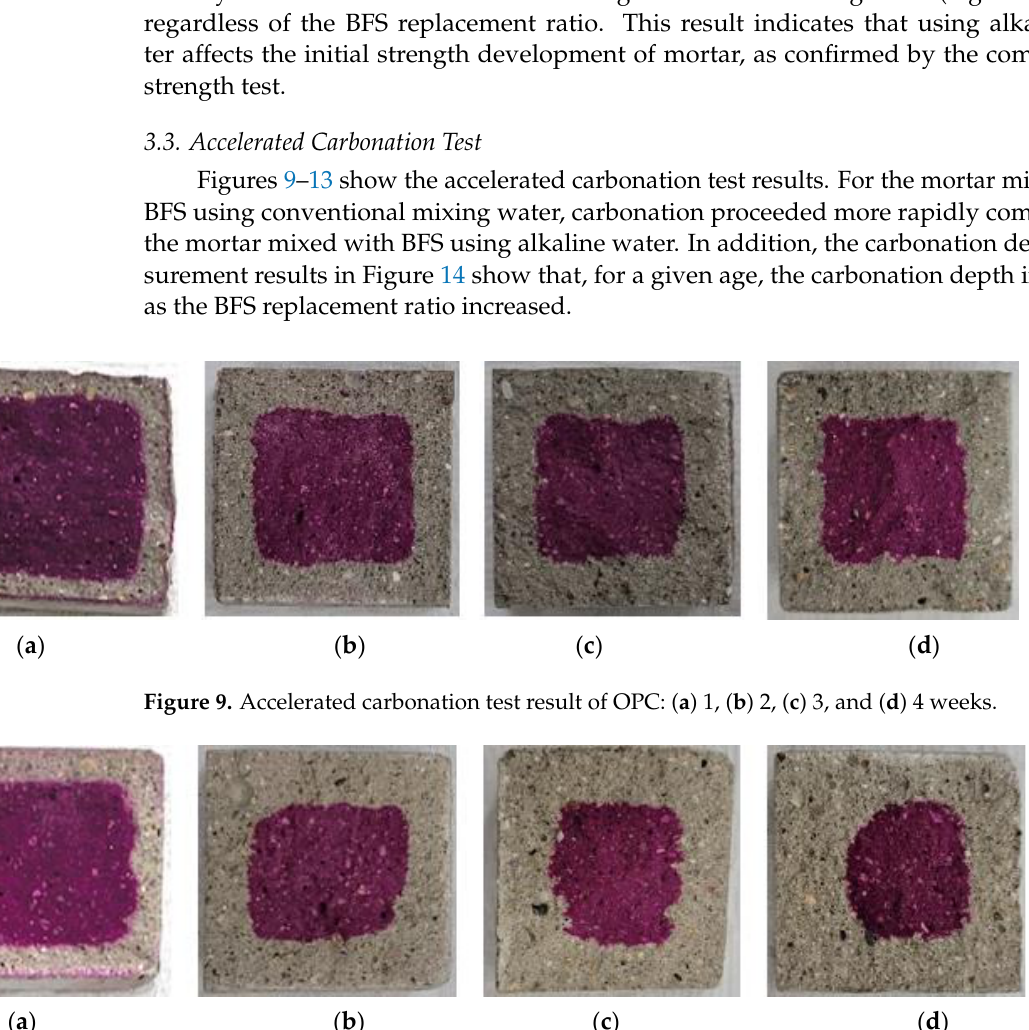
Figure 8. SEM results of ABFS50: ( a ) 3, ( b ) 7, and ( c ) 28 d.